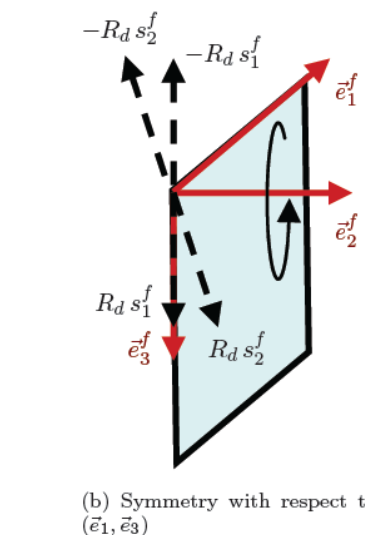
Figure 1. Symmetry with respect to the normal vector (cid:126)n to the plane Π ( a) ; the symmetry with respect to the plane ( (cid:126)e f